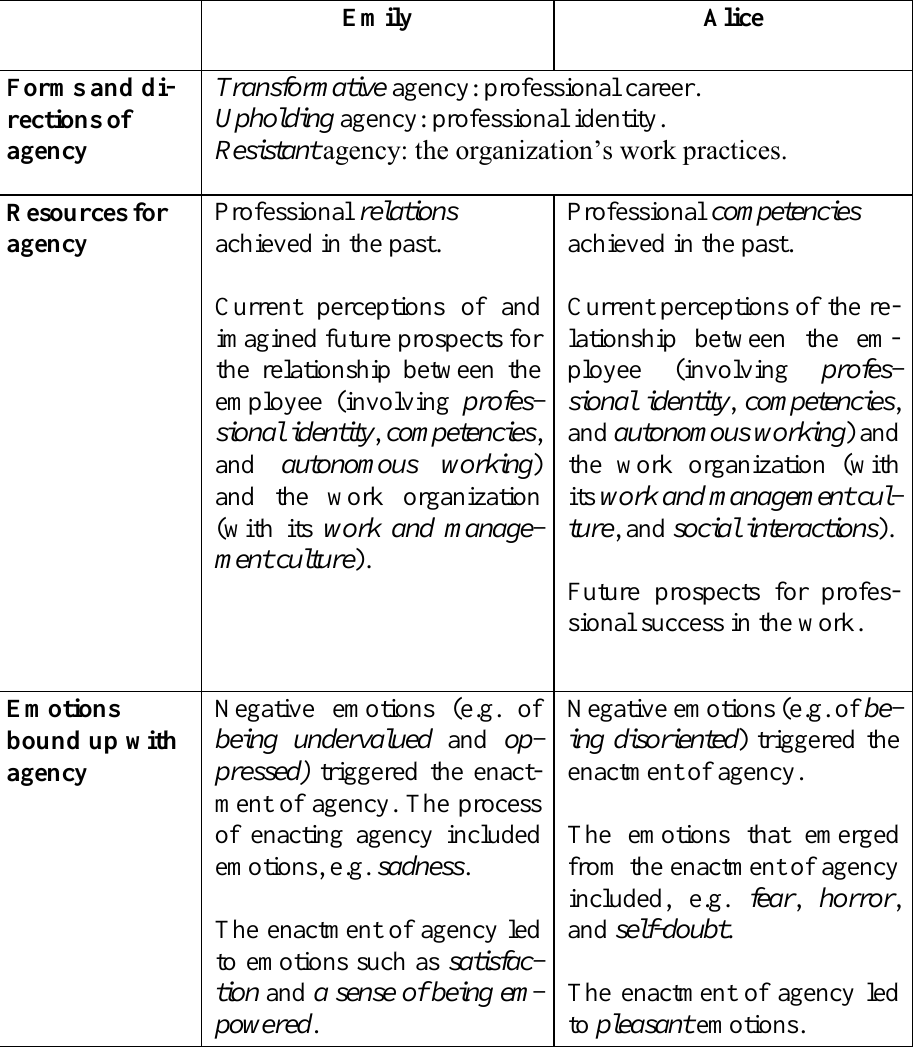
Table 1 Forms of professional agency, plus resources and emotions related to agency . Emily